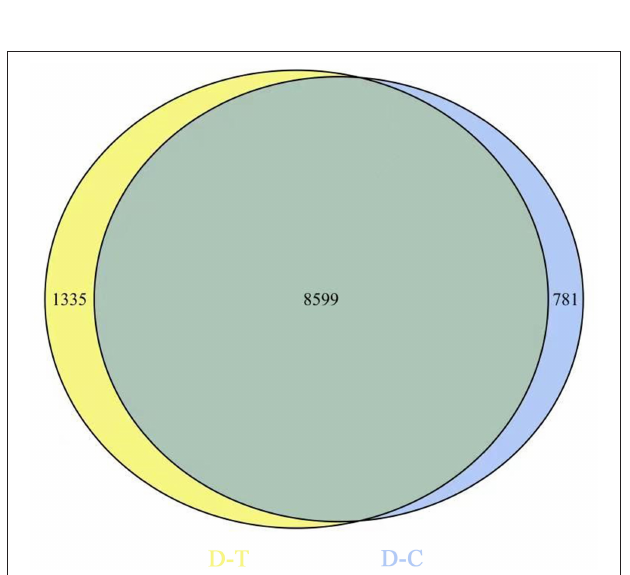
FIGURE 2 | Gene expression-level comparison between control and nanoemulsion treatment: (A) FPKM distribution (Fragments Per Kilobase of transcript sequence per Millions of base pairs sequenced) and (B) FPKM density distribution.